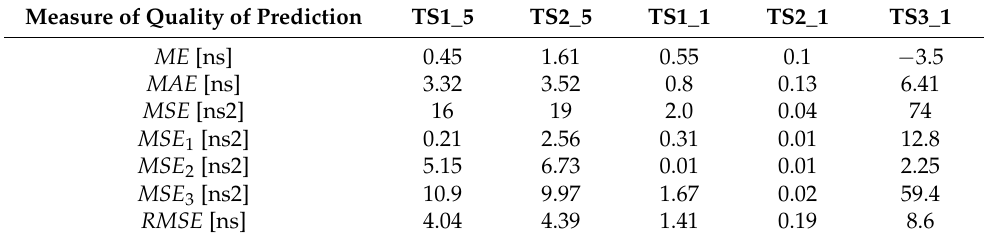
Table 1. Obtained values of selected quality prediction measures for the TS1_5, TS2_5, TS1_1, TS2_1, and TS3_1. Measure of Quality of